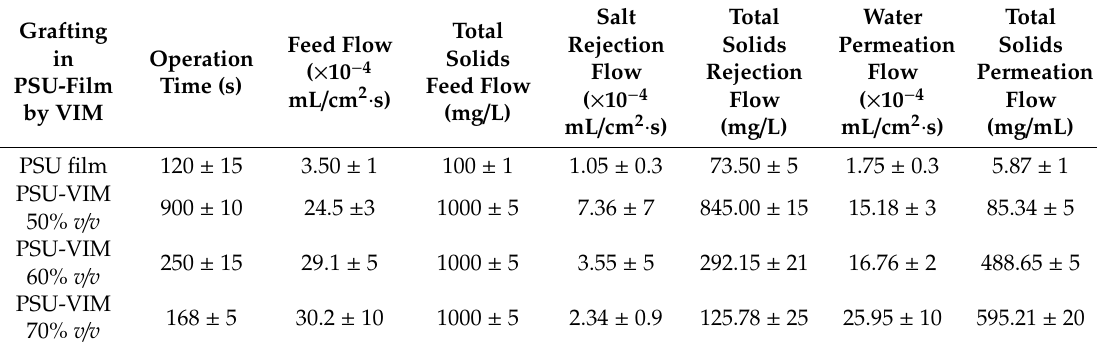
Table 3. Data of constant flows and total solids from the desalination test of the grafted PSU-VIM (50–70% v / v